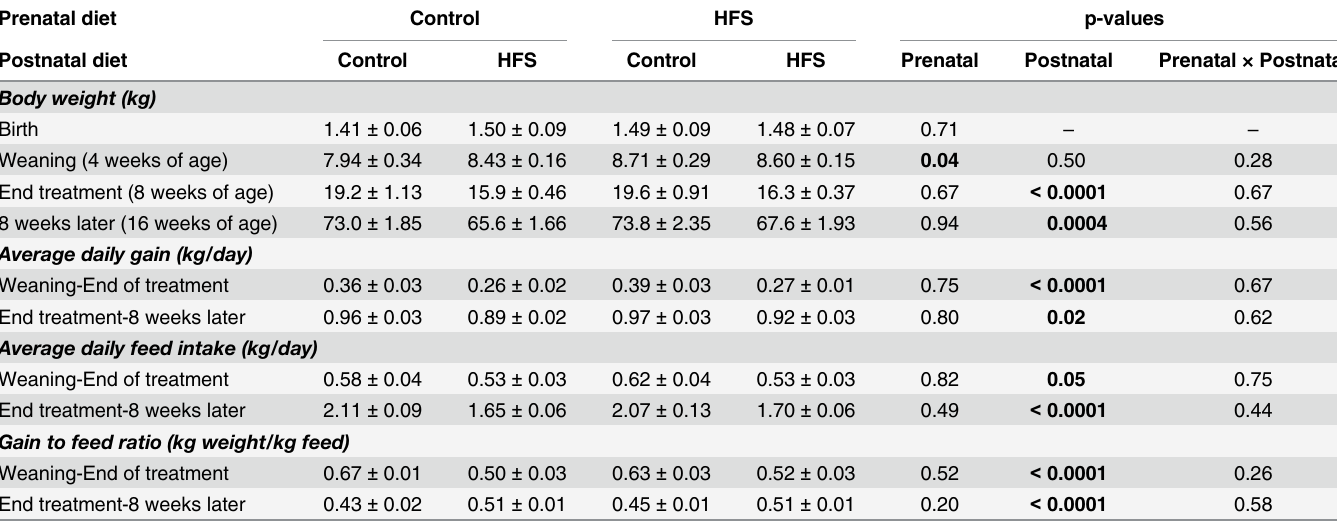
Table 2. Body weight and average daily feed intake of piglets after